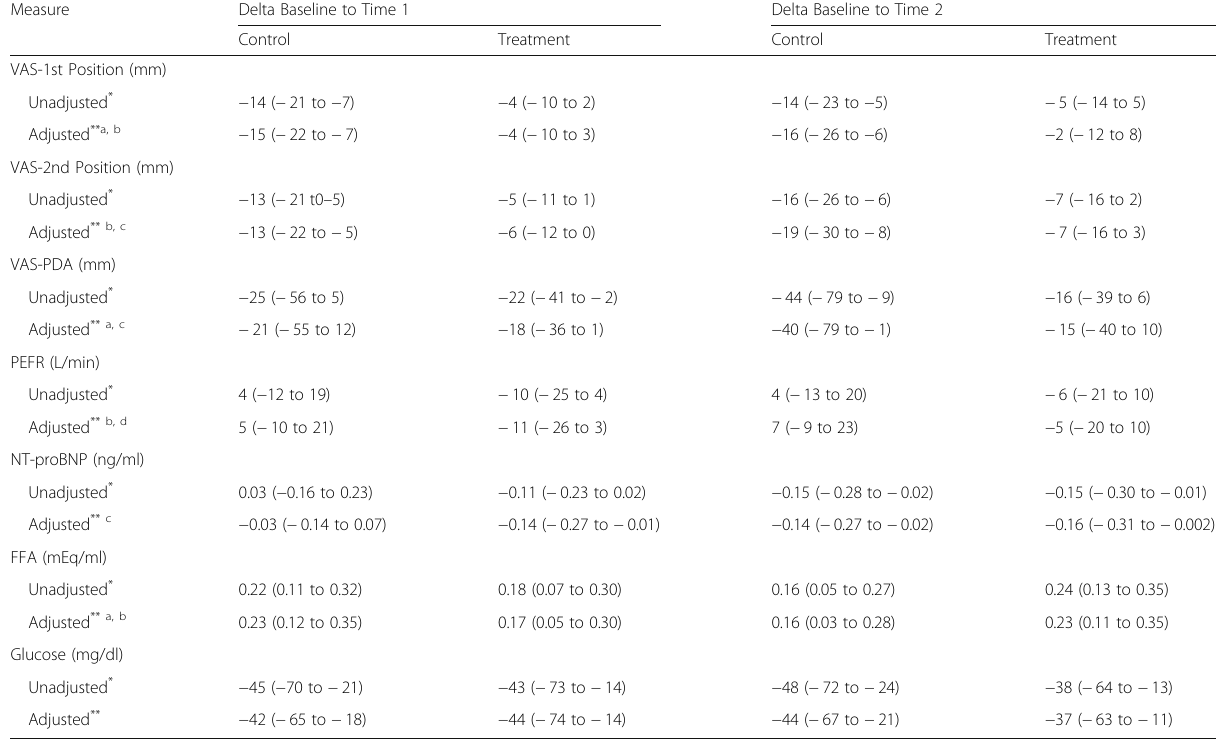
Table 4 Mean difference and 95% CI over time compared to baseline Measure Delta Baseline to Time 1 Delta Baseline to Time 2 Control Treatment Control Treatment